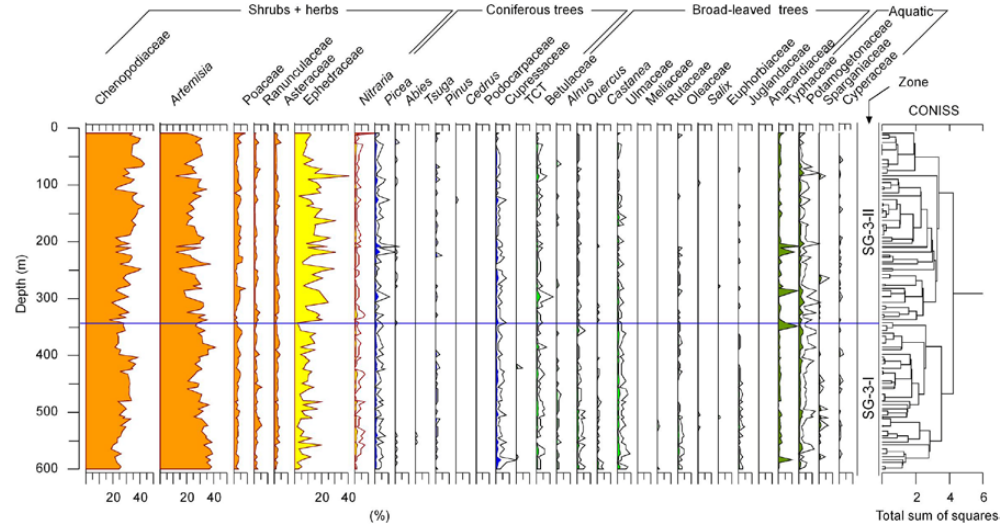
Fig. 4. SG-3 core pollen diagram in the western Qaidam Basin adapted from Cai et al. (2012) (TCT: 758 Taxodiaceae/ Cupressaceae/ Taxaceae). 759